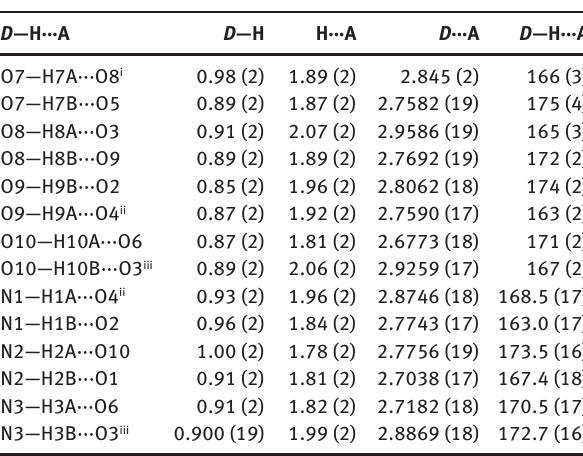
Table 1 Hydrogen-bond geometry (Å, ° ).